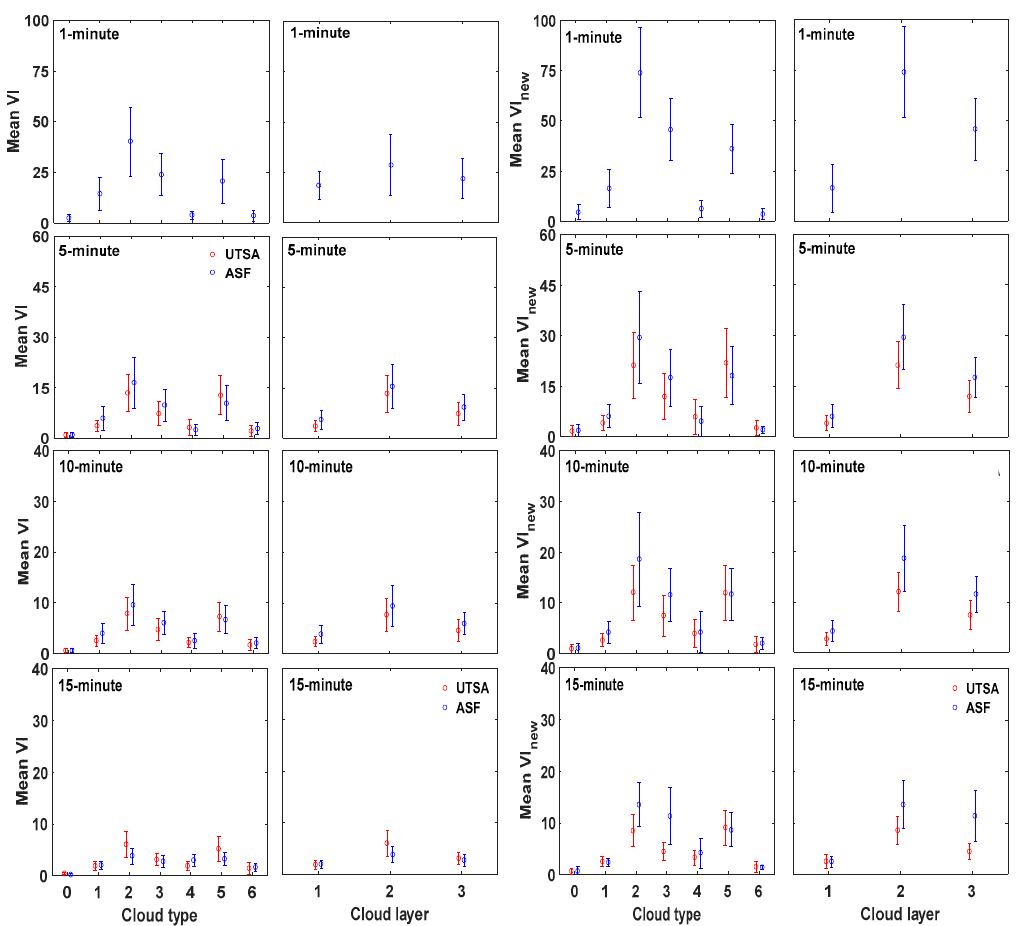
Figure 9. The mean variability index, VI ( left two panel columns ) and VI new ( right two panel columns ) with their ±1 standard deviation error bars plotted against cloud types and cloud layers.